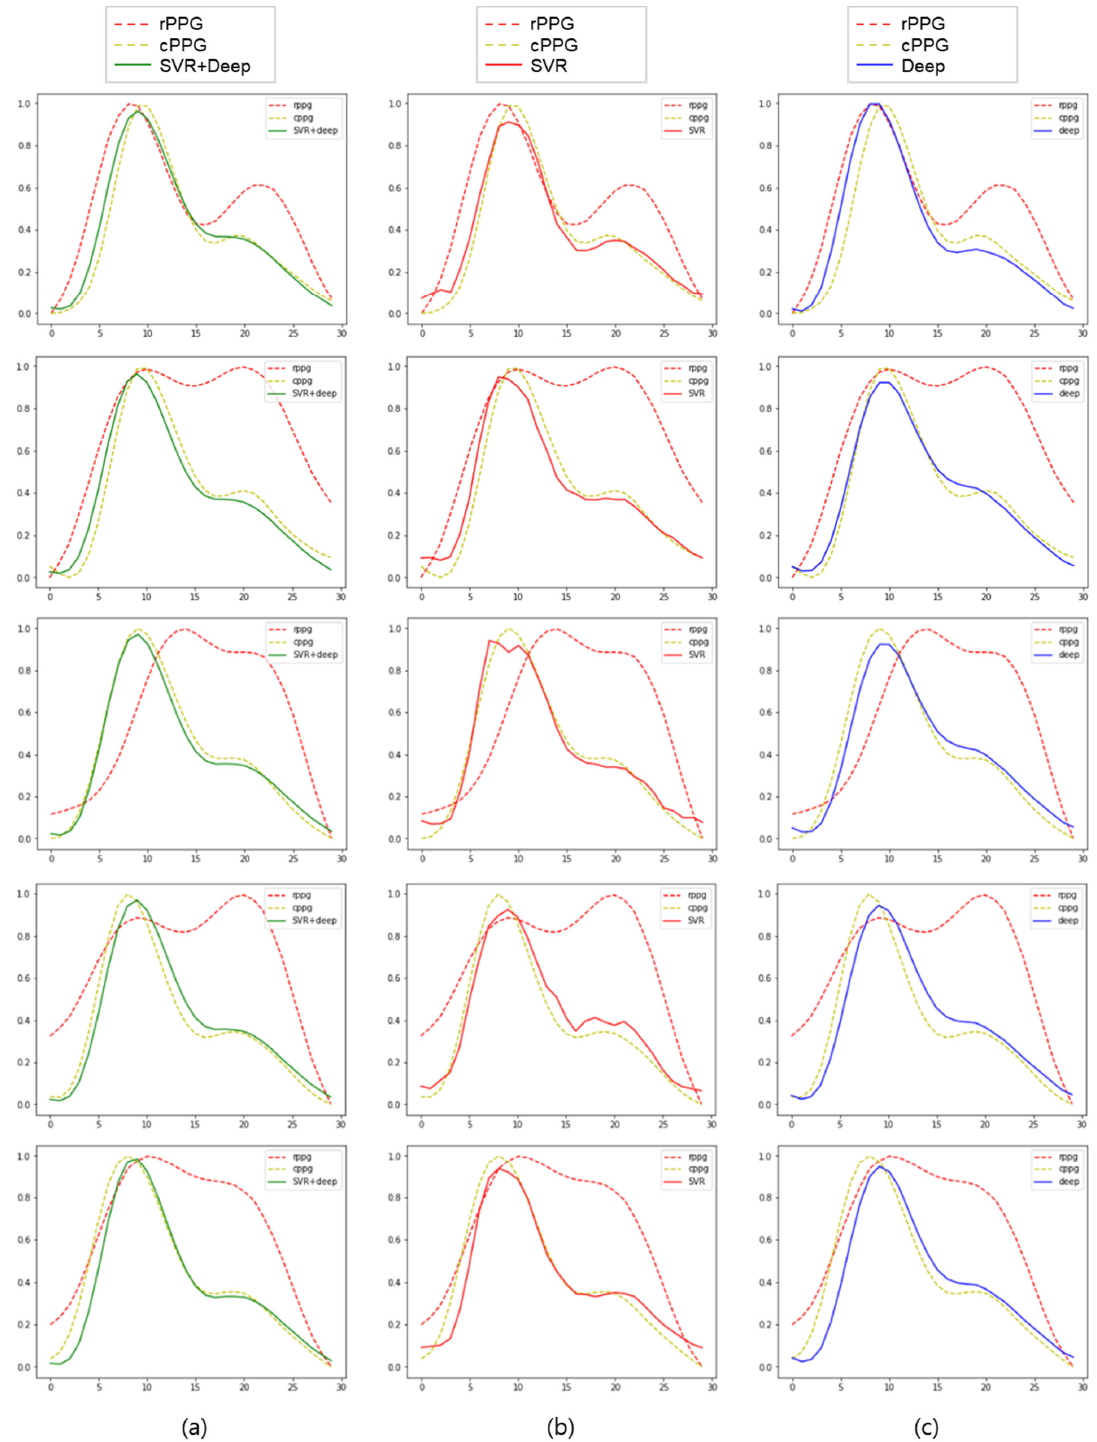
Figure 7. Some of the results of applying the training model to new data: ( a – c ) cPPG signal (yellow dotted line) and rPPG signal (red dotted line); ( a ) SVR + deep results (green solid line); ( b ) SVR results (red solid line); ( c ) deep learning results (blue solid